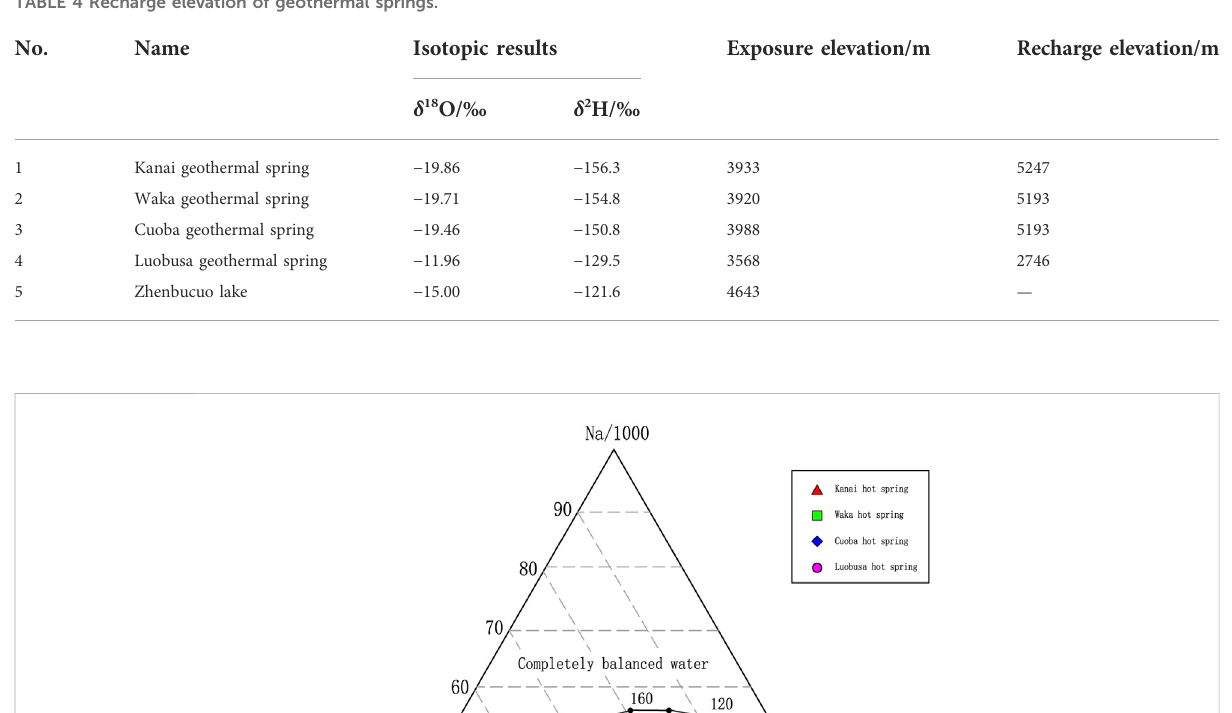
TABLE 4 Recharge elevation of geothermal springs.